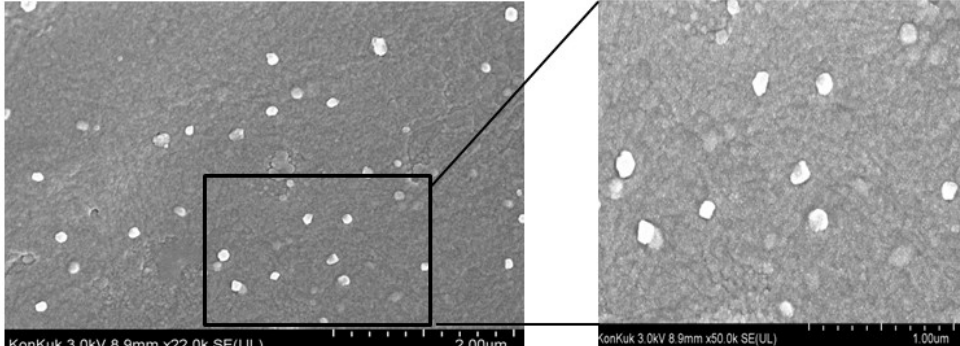
Figure 3. Silver nanoparticles induce biogenesis and secretion of exosomes in SH-SY5Y cells cultured with serum-free medium.